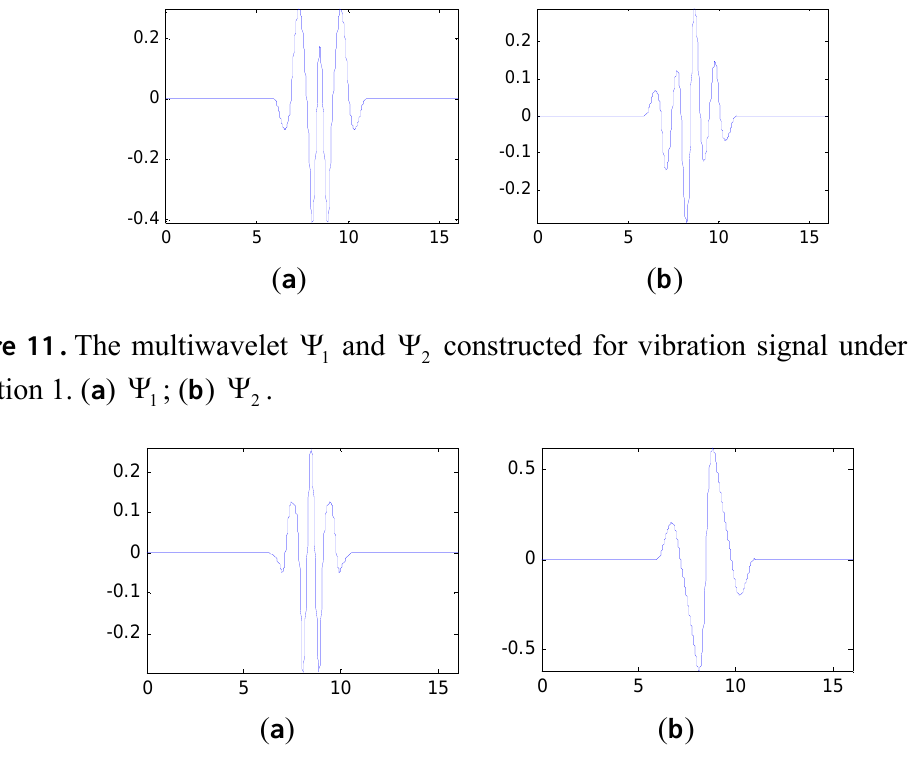
 and  constructed for vibration signal under assembly 1 2  ; ( b )  1 2